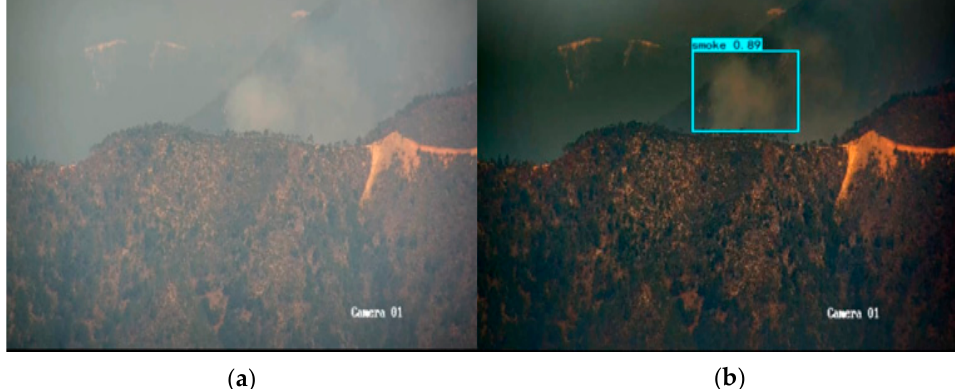
Figure 8. Comparison of forest fire detection result in foggy environment by ( a ) YOLOX-L-Light and ( b ) GLXD.